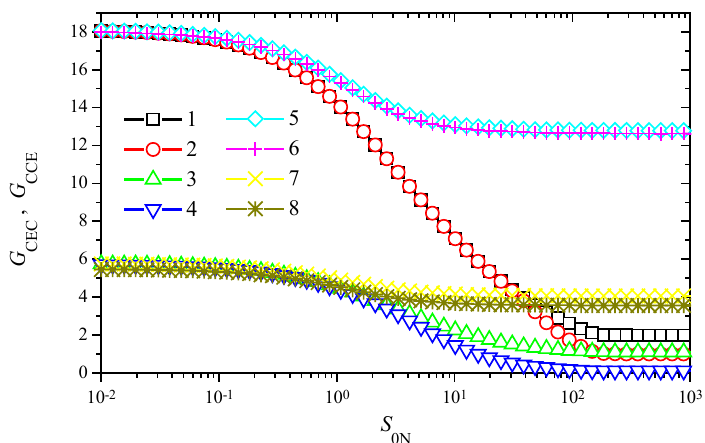
(1, 3, 5, 7) and G (2, 4, 6, 8) vs. the substrate concentration CEC CCE : 100 (1-4), 1 (5-8) and V : 100 (1, 2, 5, 6), 10 (3, 4, 7, 8) 1 2